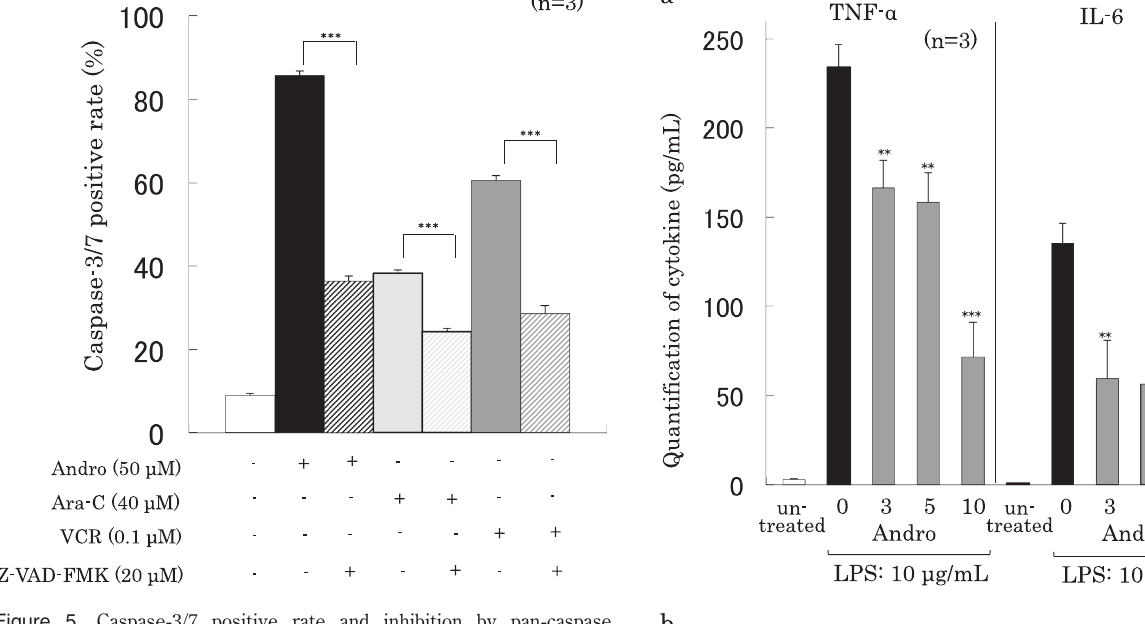
Figure 5 Caspase-3/7 positive rate and inhibition by pan-caspase inhibitor. The caspase-3/7 activities of the cells incubated with Andro, Ara-C or VCR in the presence or absence of Z-VAD-FMK for 24 h were assayed. The caspase-3/7 activities were increased after addition of Andro, Ara-C or VCR, but were significantly inhibited in the presence of pan-caspase inhibitor. Results are expressed as mean±SD of three independent experiments (***P<0.001, as compared with or without inhibitor).